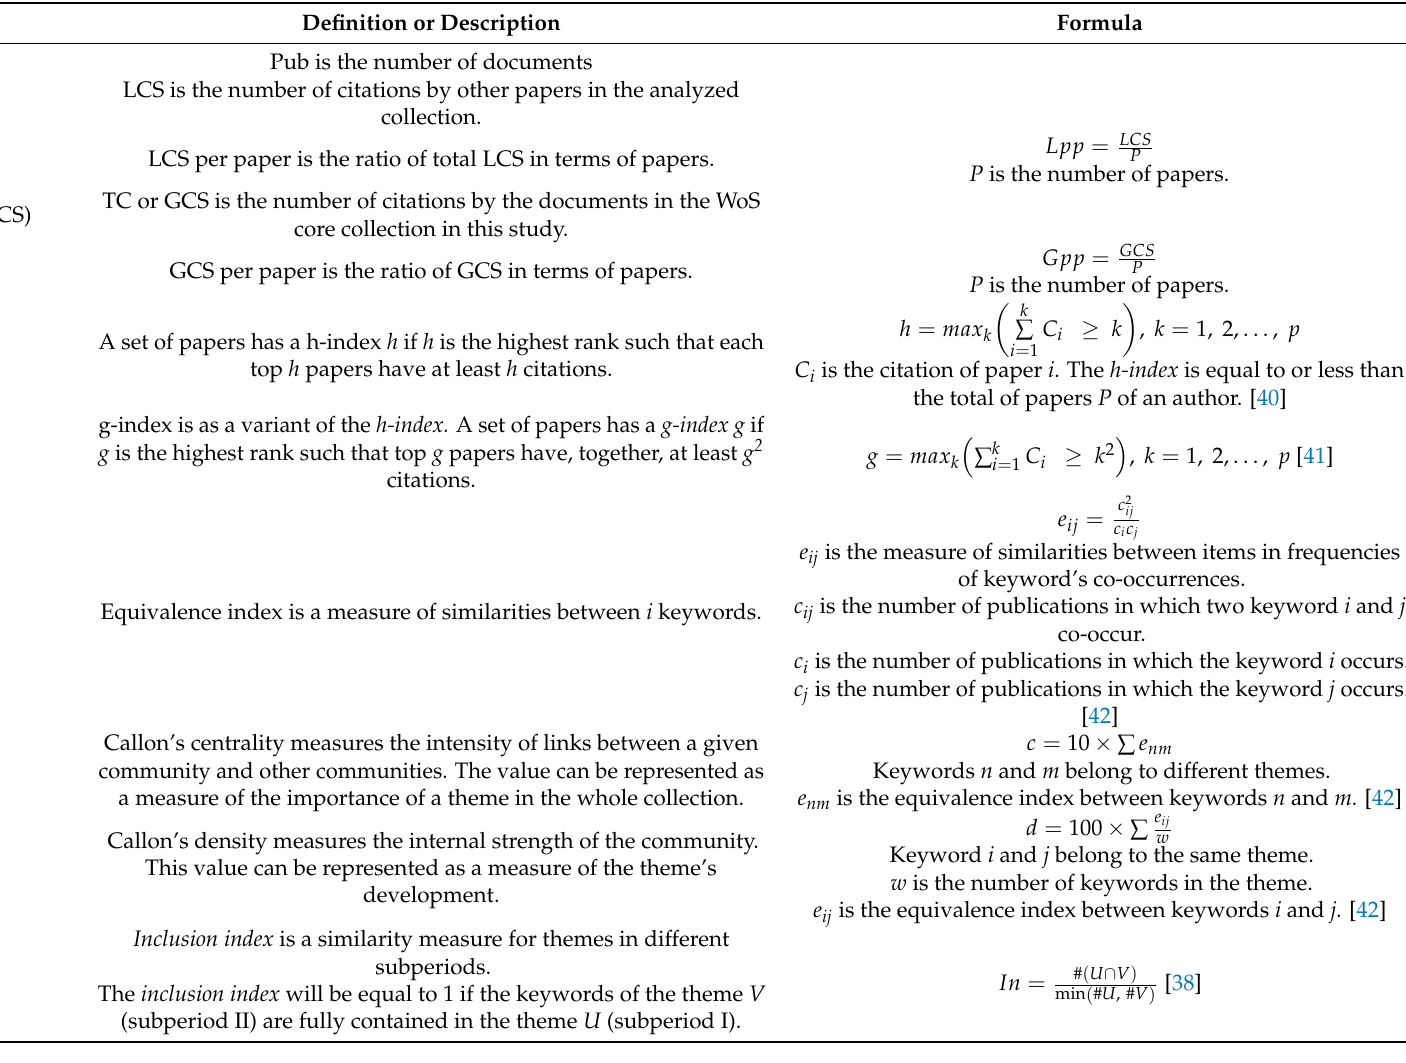
Table 1. Bibliometric indicators and their